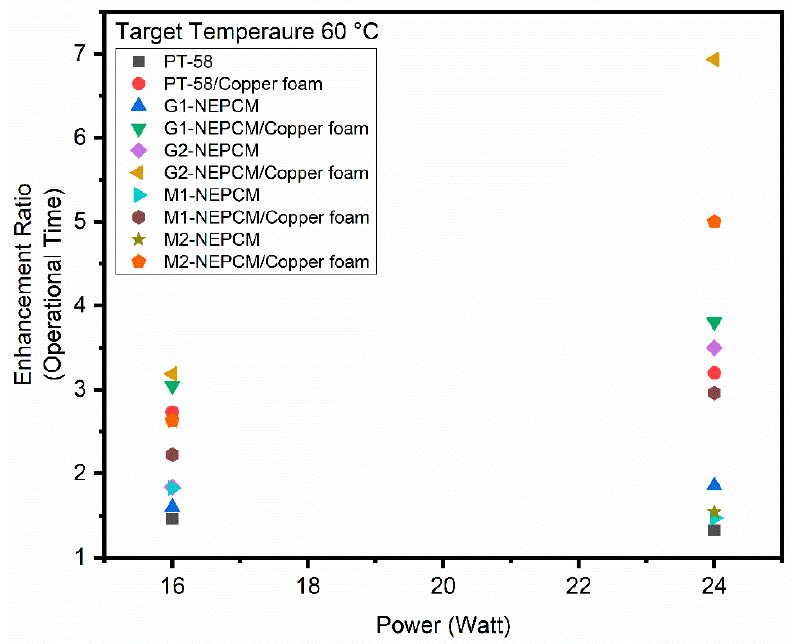
Figure 23. Enhancement ratios comparison for various heat sink configurations at operational time of 60 ℃.